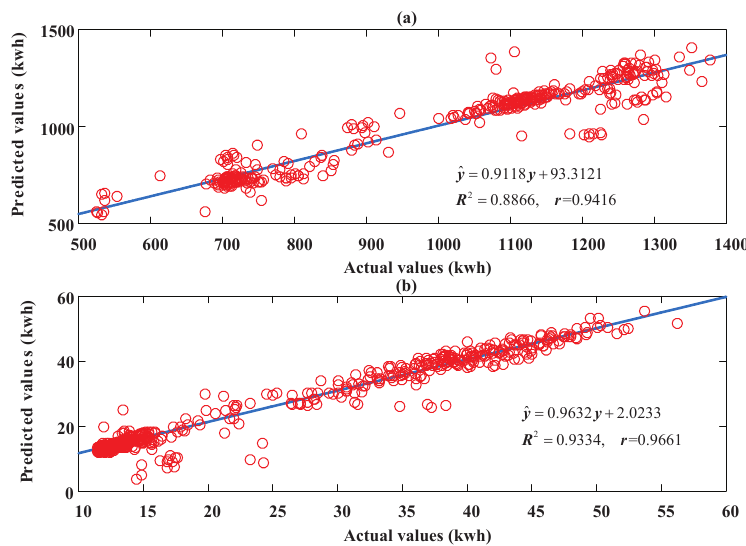
Figure 14. Scatter plots of the actual and predicted values of the energy consumptions in the retail building ( a ) and the office building ( b